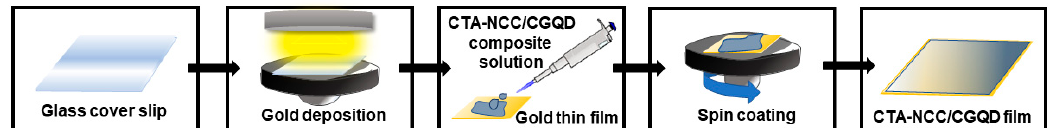
Figure 1. Preparation of hexadecyltrimethylammonium bromide (CTA)-nanocrystalline cellulose (NCC) / carboxyl-functionalized graphene quantum dots (CGQD) thin film.